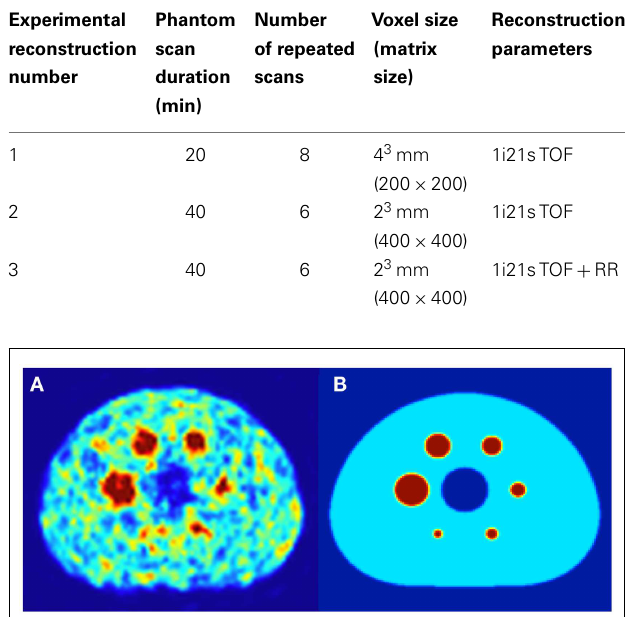
Table 1 | Reconstruction parameters for 90 Y phantom scans